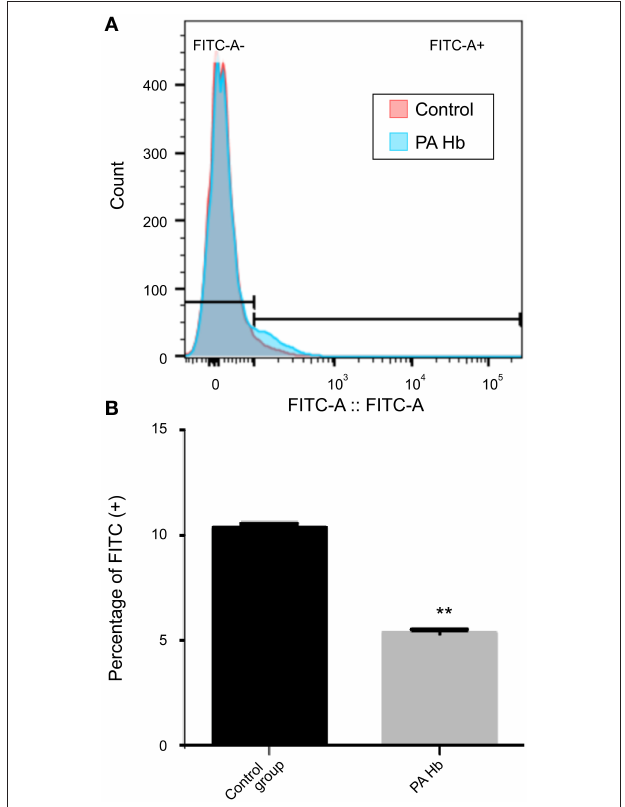
FIGURE 5 | PA Hemoglobin decreases apoptosis through reduction in ROS generation. Cells were treated with and without PA Hb for 72h at the concentration of 0.625 µ g/mL. (A) Representative histogram layout image of stained cells. (B) Percent cell population of FITC positive cells. ** p < 0.01. Results are expressed as means ± SEM. Statistical analysis was performed using the Student’s t -test and the control group was used for comparison. ROS, reactive oxygen